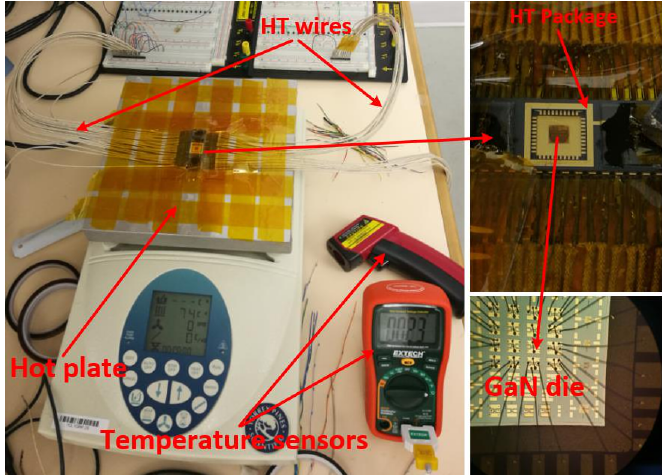
Figure 2. Experimental setup for HT GaN500 device characterization.